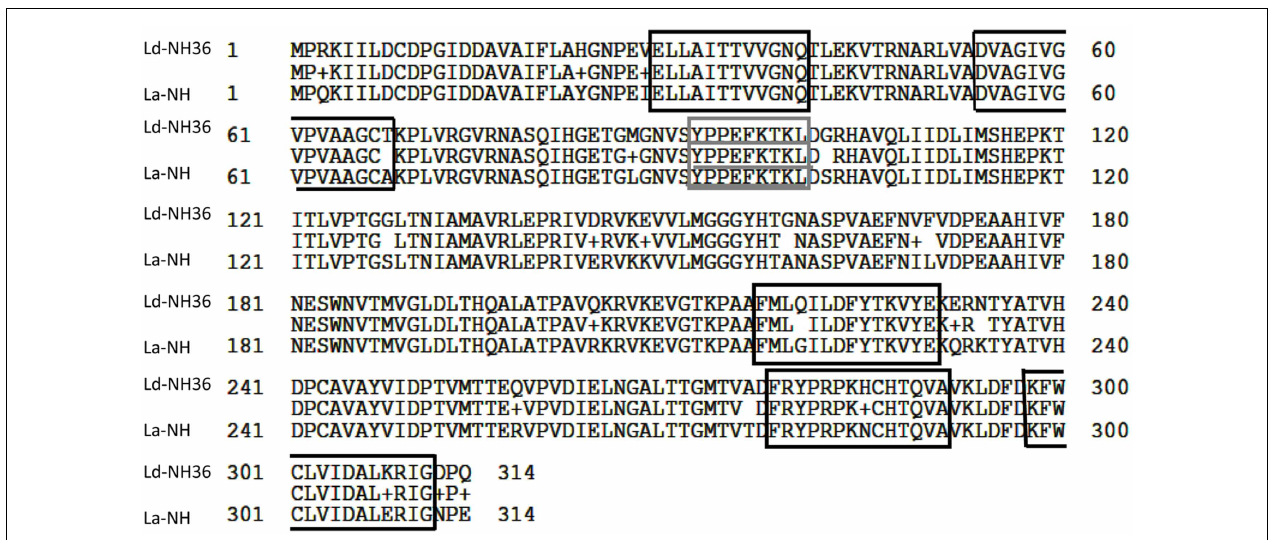
amino acids share by the two NHs.The peptide sequence of MHC class II-IA d and -IE d , haplotype H 2 CD4 + T cell epitopes (34) are shown in black squares, on the F1 and F3 fragments.The amino acid sequence of MHC class I L d -CD8 + T cell predicted epitope of the F1 fragment (34) is underlined in the gray